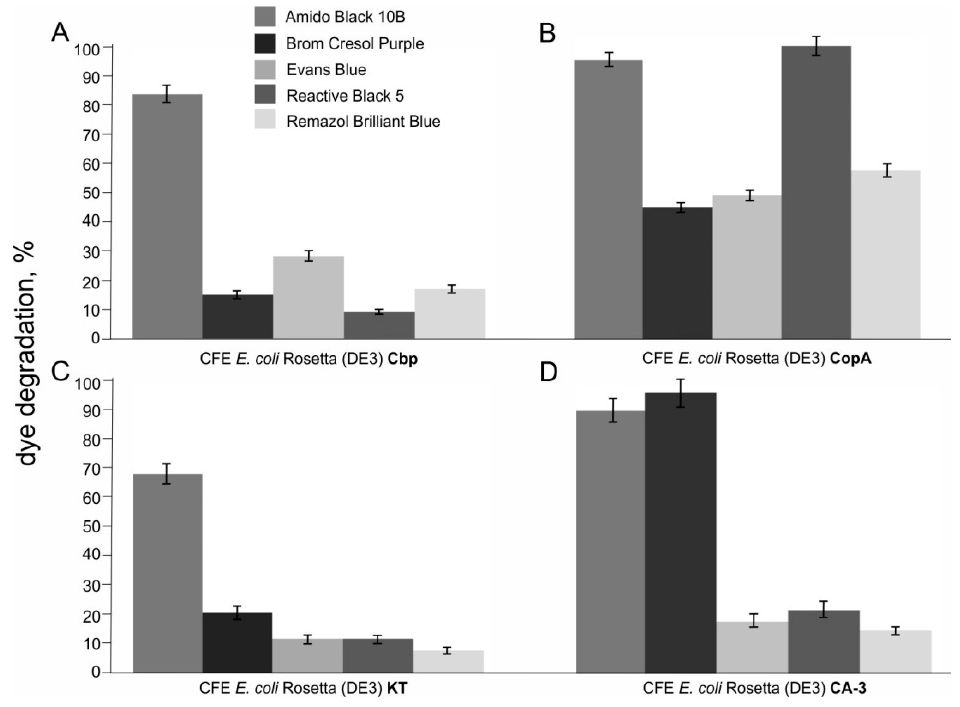
Figure 5. Degradation of five synthetic textile dyes using cell-free extracts (CFE) of E. coli Rosetta (DE3) expressing laccases: ( A ) Cbp from P. putida F6; ( B ) CopA from P. putida F6; ( C ) KT from P. putida KT2440; and ( D ) CA-3 from P. putida CA-3.